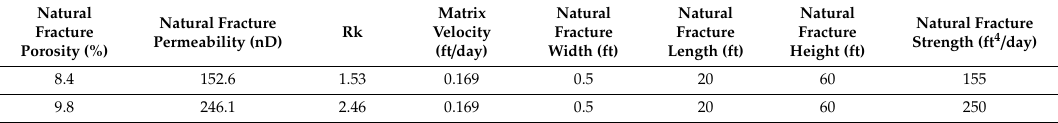
Table A2. Natural fracture strength from Carman–Kozeny